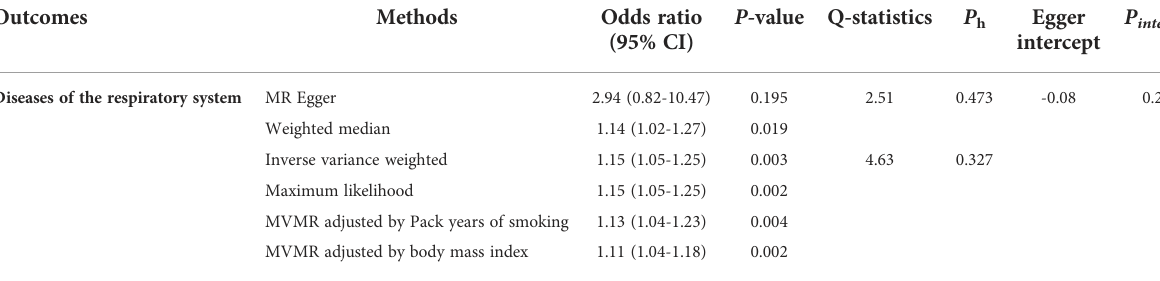
TABLE 3 Two-sample Mendelian randomization estimations showing the effect of trauma exposure on the risk of diseases of the respiratory system. Outcomes